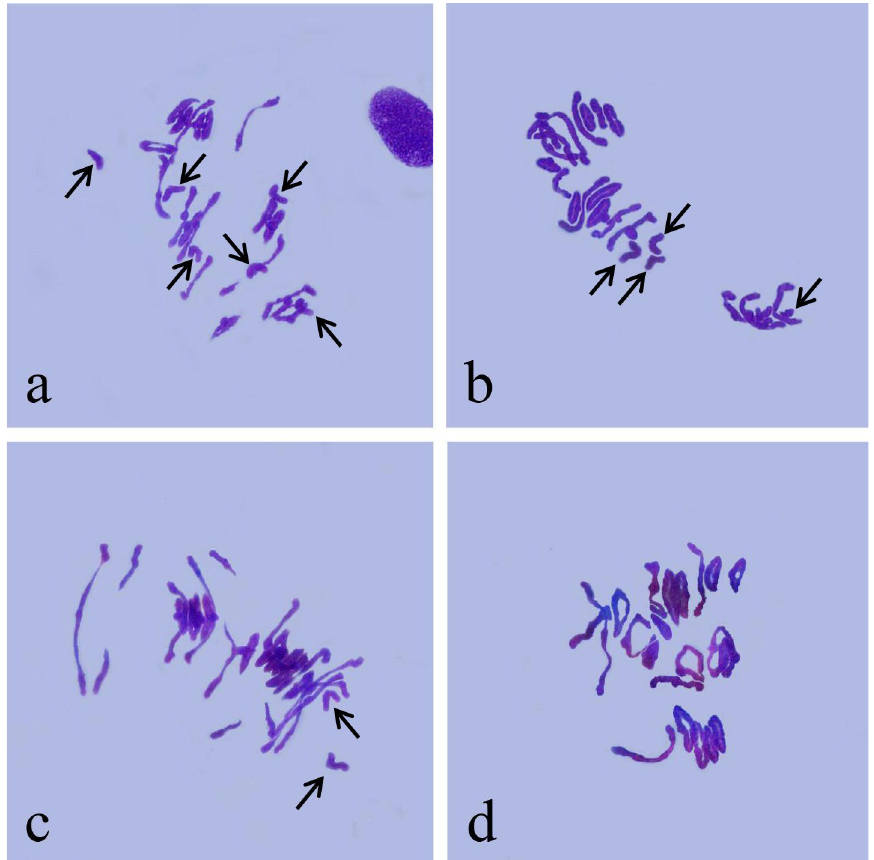
Figure 8. Chromosome pairings of pollen mother cells at meiotic metaphase I in synthetic hexaploid wheat. ( a ): Syn-SAU-116 (6I + 18II); ( b ): Syn-SAU-117 (4I + 19II); ( c ): Syn-SAU-118 (2I + 20II); ( d ): Syn-SAU-119 (21II). Arrows indicate